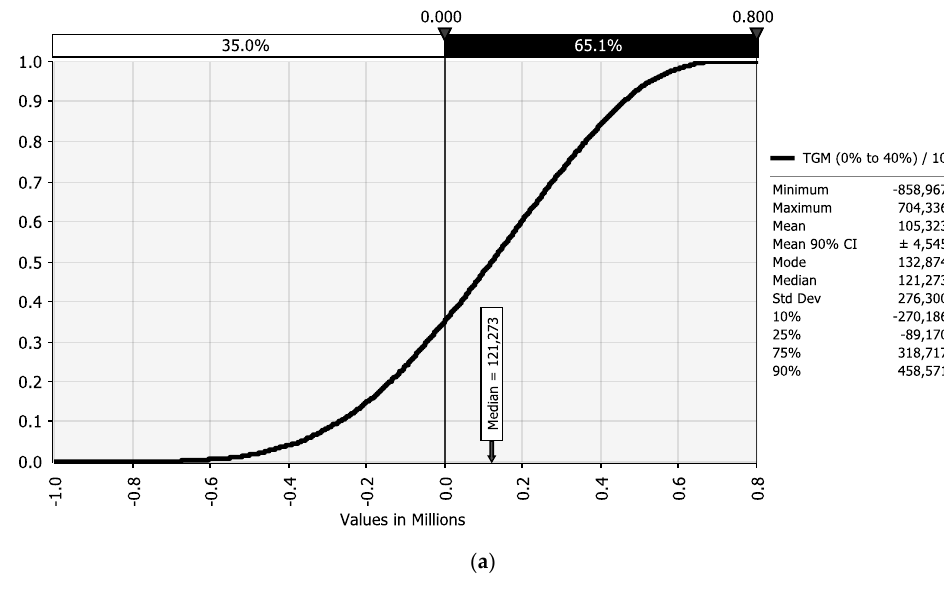
(Figure 4c) of the time at the end of Year 10 for the five scenarios, i.e., 0% to 40% opening D:E ratios, respectively.